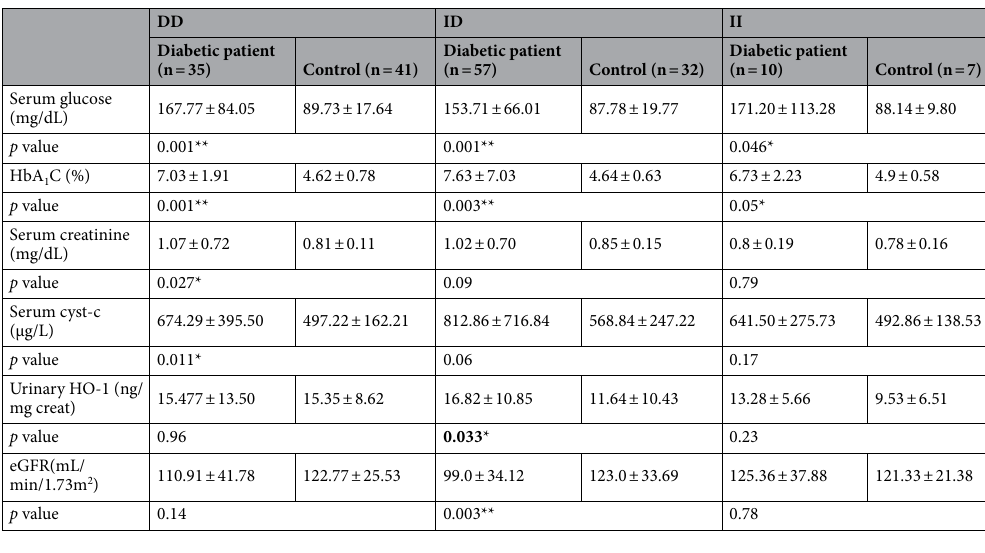
Table 5. Levels of studied biochemical parameters in different ACE I/D genotypes in diabetic patient and control groups. **High significant p < 0.001, *significant at p < 0.05.